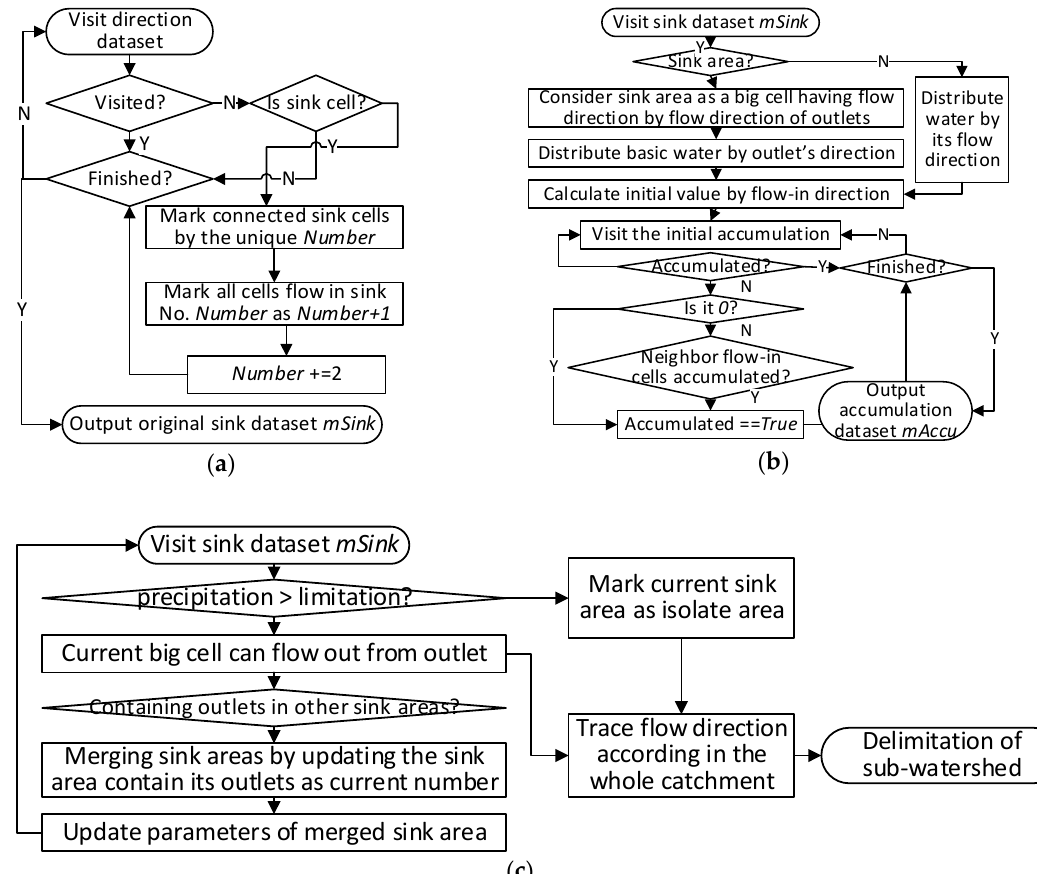
Figure 3. Flow chart of the main process of watershed delimitation. Figure ( a ) shows the process of identify basic units, Figure ( b ) shows the process of calculating the accumulative flow, and Figure ( c ) shows the process of watershed delimitation.